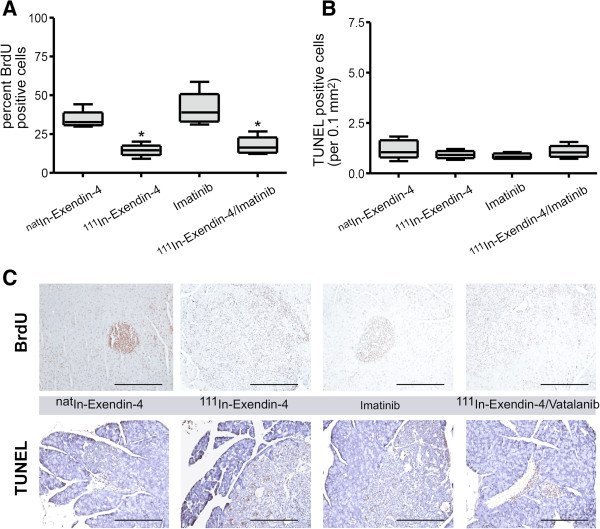
Proliferation and apoptosis of tumor β-cells treated with [Lys40(Ahx-DTPA-111In)NH2]-exendin-4 and/or imatinib. (A) Proliferation of tumor beta-cells of Rip1Tag2 mice treated with [Lys40(Ahx-DTPA-111In)NH2]-exendin-4 and [Lys40(Ahx-DTPA-111In)NH2]-exendin-4 plus imatinib is reduced compared to the natIn-exendin-4 and the imatinib group (*p < 0.05, Newman-Keuls post-test). (B) However, the combined treatment modality does not increase tumor cell apoptosis compared to the other groups (p > 0.05, Newman-Keuls post-test). (C) Immunohistochemistry for proliferation (BrdU, top row) and apoptosis (TUNEL, bottom row) on the sections of Rip1Tag2 pancreas treated as indicated on the graph. Size bars, 100 μm.